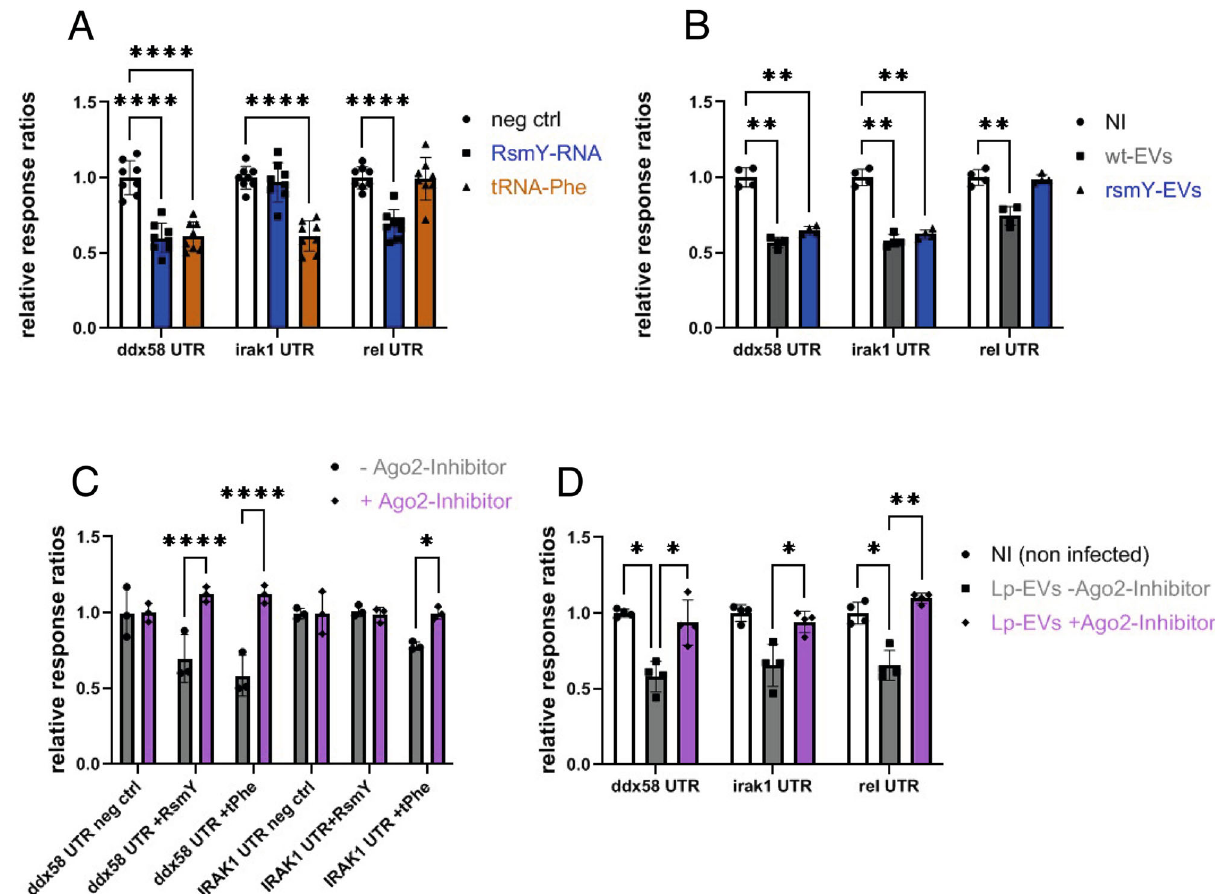
Fig. 4 RsmY base pairs with the UTR of RIG-I and RsmY activity is modulated by Ago2 inhibition. A Dual luciferase reporter assay showing luciferase activities of THP-1 cells transfected with random short Lp -RNA (ctrlRNA), RsmY, or tRNA-Phe. Results are shown as relative luciferase activity (ratio Fire fl y/Renilla activity), where luciferase activity of ctrlRNA is de fi ned as 100%. Bars indicate the (mean) SD of eight independent experiments. For statistical analysis, a two-way ANOVA was performed with p < 0.0001 (****). Source data provided as Source data fi le. B Dual luciferase reporter assay showing luciferase activities of THP-1 cells in absence (NI) or presence of wt or a Δ rsmY Lp -EVs. Lp -EVs affect protein expression depending on the presence of the un-translated regions (UTR) of ddx58 (RIG-I), irak1 , or rel (cRel). Results are shown as relative luciferase activity (ratio Fire fl y/Renilla activity), luciferase activity of THP-1 cells (NI) was de fi ned as 100%. Bars show the (mean) SD of n = 7 independent experiments. Statistical analysis,